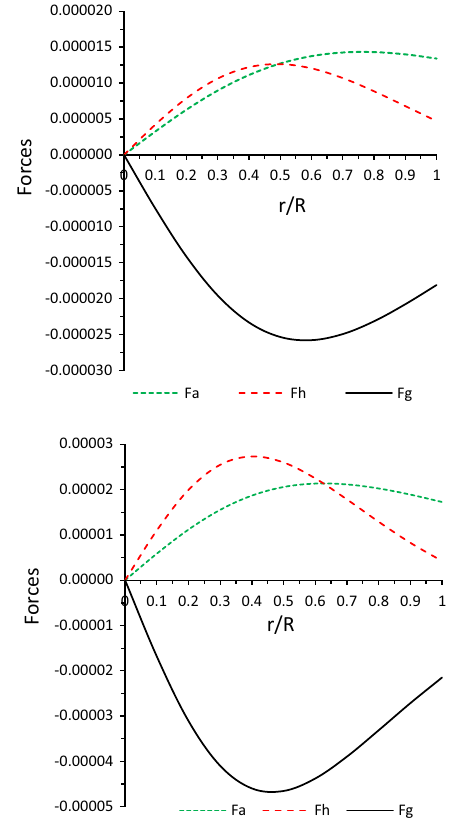
b = 0 . 0025, c = 0 . 01074, A = 0 . 4905, B = 1 . 2293, M = 1 . 3 M (cid:7) and